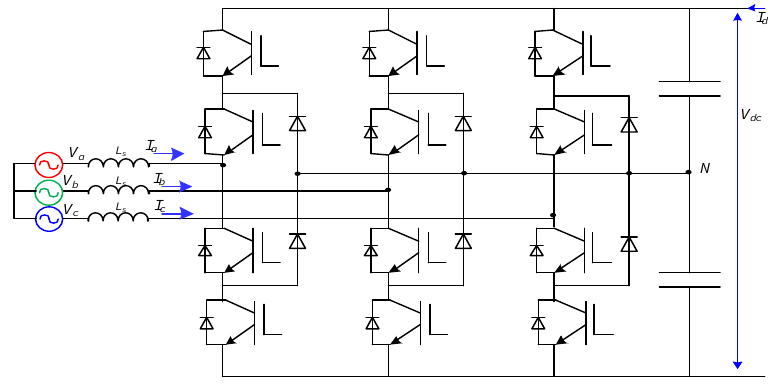
Figure 2. Three-phase three-level (TPTL) AC/DC converter.